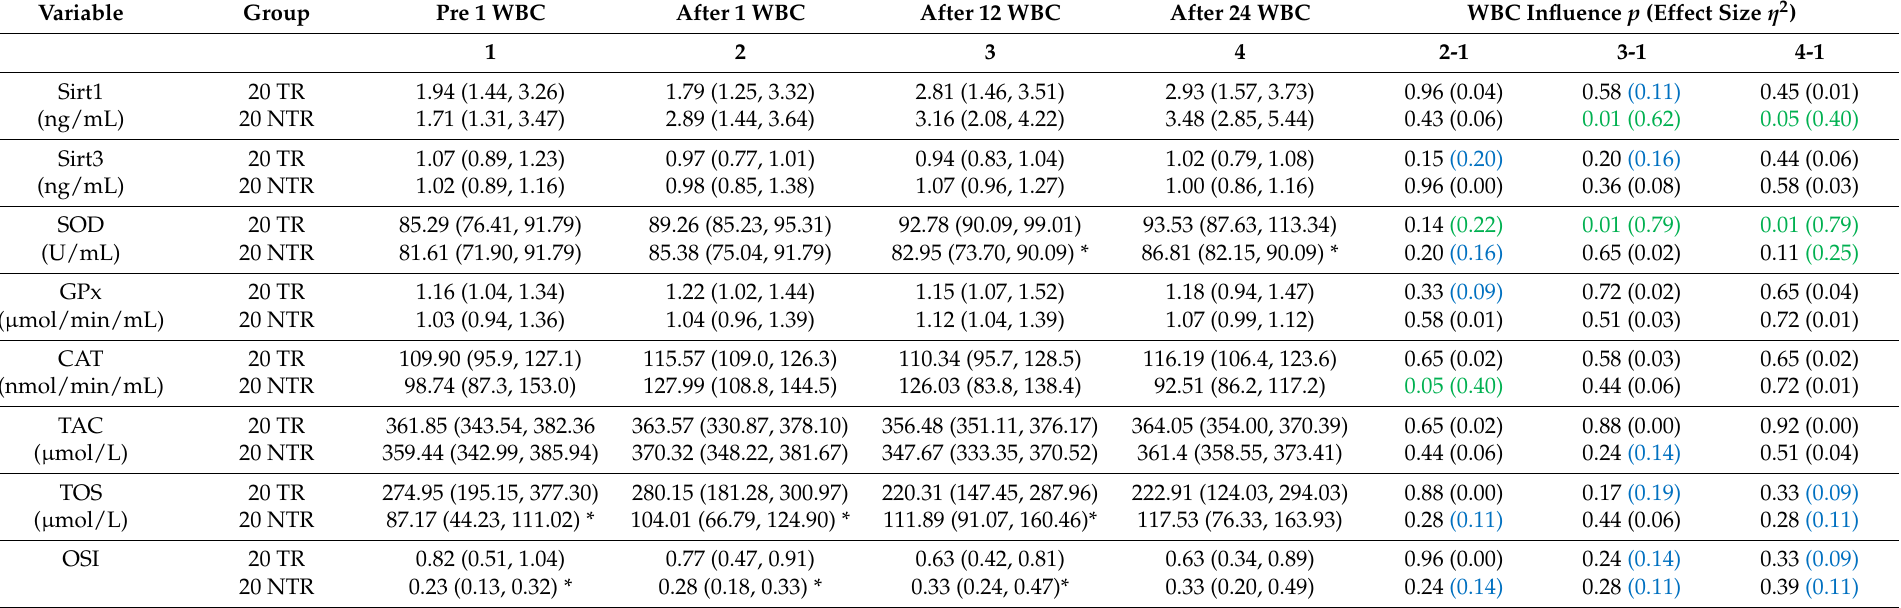
Table 4. Level of sirtuins and markers of oxidative stress in young males before and after the application of whole-body cryotherapy